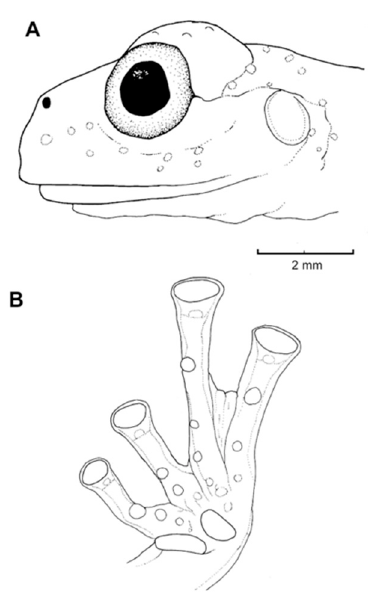
Figure 55. Centrolene pipilata , KU 143278, holotype. ( A ) Head in lateral view. ( B ) Hand in ventral view. Illustrations by Juan M. Guayasamin.